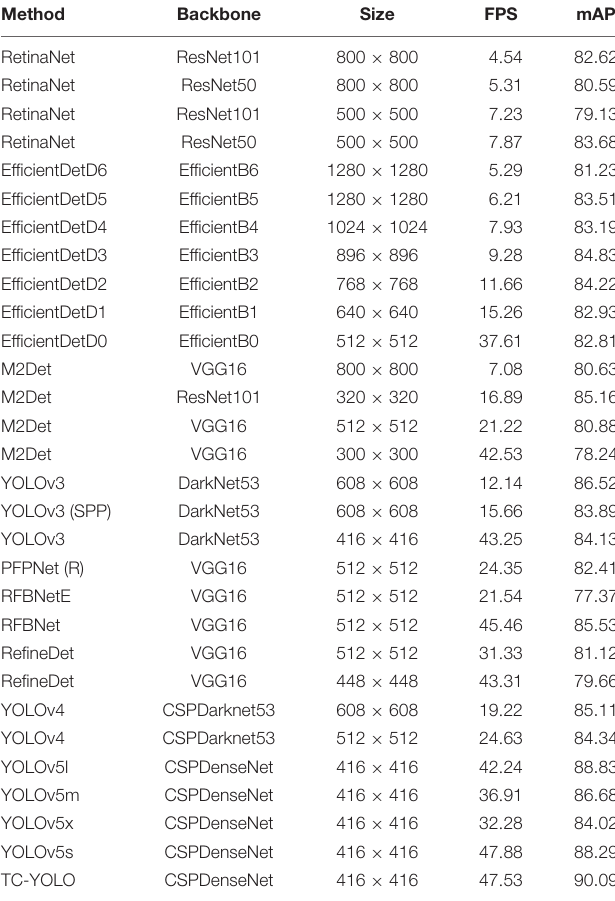
TABLE 4 | Comparisons with state-of-the-art detection methods.